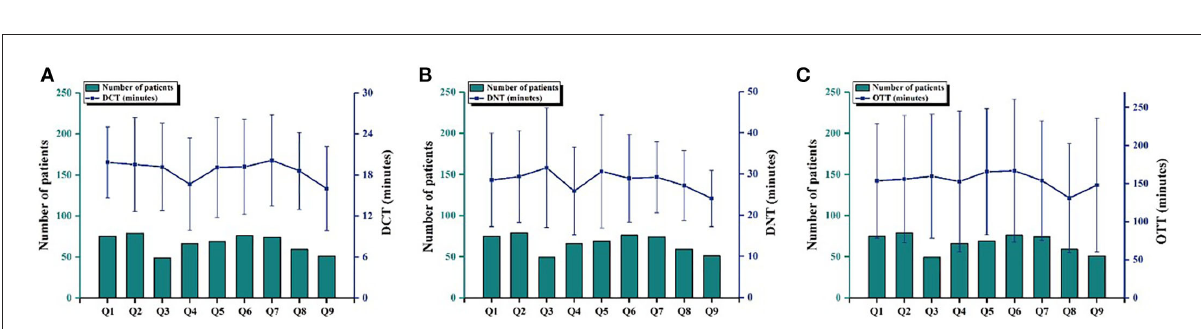
FIGURE4 The changes in time points and the number of AIS patients with intravenous thrombolysis in the pre-intervention and post-intervention groups. Number of patients and mean DCT (A) , DNT (B) , and OTT (C) with standard deviation for AIS patients with intravenous thrombolysis in the post-intervention group during nine quarters (from August 2017 to September 2019, in which 3 months was a quarter, except for the ninth quarter which only had 2 months). DCT, door-to-CT time; DNT, door-to-need time; OTT, onset-to-treatment time; CT, computed